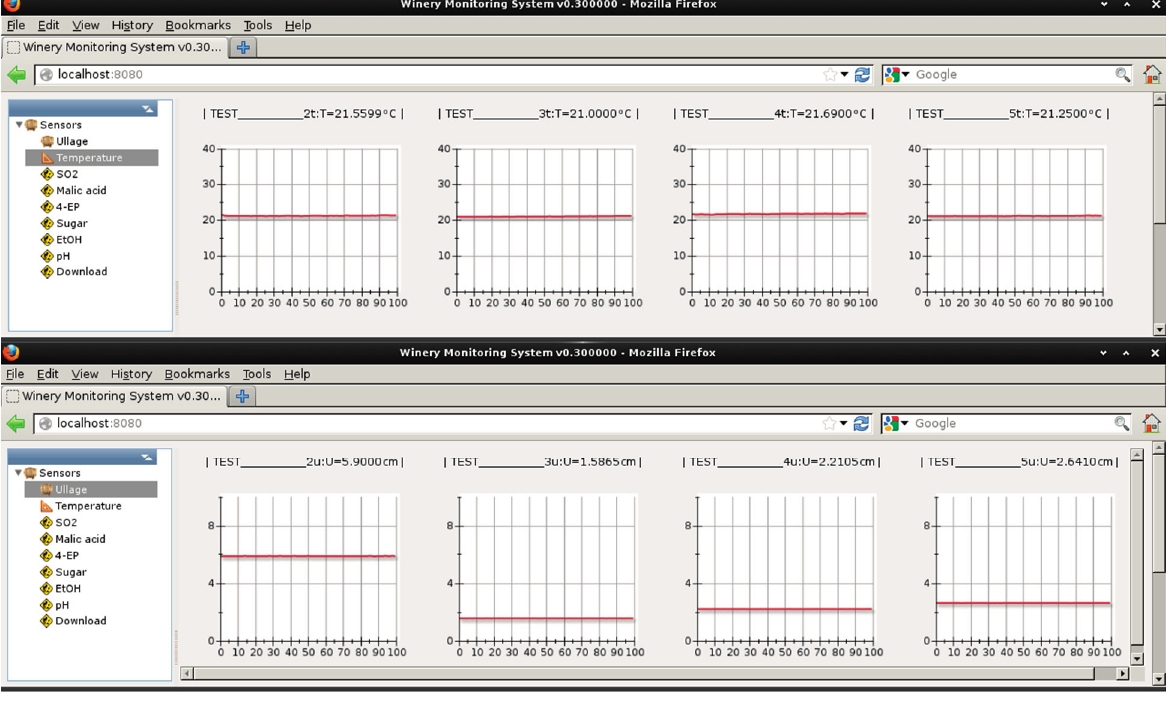
Figure 3. The temperature sensor page of the web interface shows eight virtual